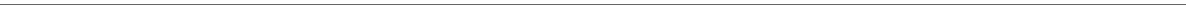
FigUre 3 | Factor X (FX) had a chemotactic ability to recruit macrophages/monocytes. (a) Western blotting showed that FX expression decreased in G1124 cell lysates and supernatants after knockdown of FX (mean ± SEM, ** p < 0.01). (B) ELISA demonstrated that the secretion of FX was reduced in G1124 cell supernatants after knockdown of FX (mean ± SEM, ** p < 0.01). (c) Representative images of macrophage-like THP-1 cells that migrated toward the supernatants from G1124 cells transfected with sh-NC and sh-FX in transwell assays. After knockdown of FX in G1124 cells, the number of migrating cells decreased (mean ± SEM, * p < 0.05, ** p < 0.01). (D) Representative images of THP-1 cells that migrated toward G1124 cell media preincubated with anti-FX (10 µg/ml) antibody or IgG. After preincubation with anti-FX antibody, the number of migrating cells decreased (mean ± SEM, * p < 0.05). (e) Western blotting detected that FX expression increased in U251 cell lysates and supernatants after transfection with pcDNA3.1-FX. (F) ELISA analysis showed FX secretion in U251 cell supernatants increased after transfection with pcDNA3.1-FX (mean ± SEM, ** p < 0.01). (g) The number of THP-1 cells migrating toward media from FX-overexpressing U251 cells was greater than that in the control by transwell assays (mean ± SEM, * p < 0.05). (h) THP-1 cells migrating toward different concentrations of recombinant FX (rFX) by transwell assays showed that FX attracted THP-1 cells in a dose-dependent manner (mean ± SEM, * p < 0.05, ** p < 0.01). (i) Representative images of mouse macrophages/monocytes that migrated toward supernatants from GL261 transfected with FX-overexpressing or control vector. The results showed that the number of macrophages/monocytes migrated toward GL261 cell supernatants were increased when FX was overexpressed (mean ± SEM, * p < 0.05). (J) The number of recruitment mouse macrophages/monocytes was decreased when GL261-FX cell supernatants were preincubated with anti-FX (10 µg/ml) antibody (mean ± SEM, ** p < 0.01). (K) p-mTOR, mTOR, p-p70S6K, and p70S6K in THP-1 cells were detected by western blot when phorbol 12-myristate 13-acetate (PMA)-primed THP-1 cells were treated with supernatants with or without rapamycin. (l) Representative histogram of analysis of p-mTOR/mTOR and p-p70S6K/ p70S6K when THP-1 treated with G1124 cell supernatants knockdown of FX in panel (K) . (M) Representative histogram of analysis of p-mTOR/mTOR and p-p70S6K/p70S6K when THP-1 treated with U251 cell supernatants overexpression of FX in panel (K) . (n) Representative histogram of analysis of p-mTOR/mTOR and p-p70S6K/p70S6K when THP-1 treated with recombinant protein FX in panel (K) . (O) THP-1 cells migrating toward cells supernatants with or without rapamycin. (P) The histogram of cell number of migrated cells in panel (O)